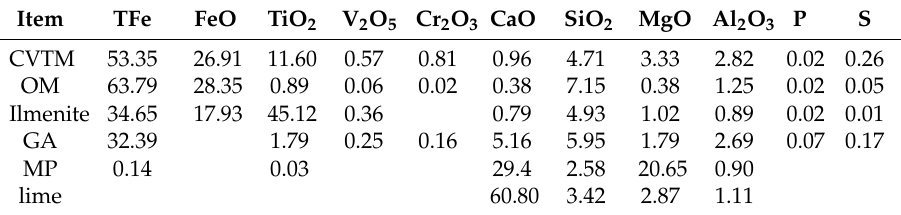
Table 3. Chemical compositions of raw materials (wt